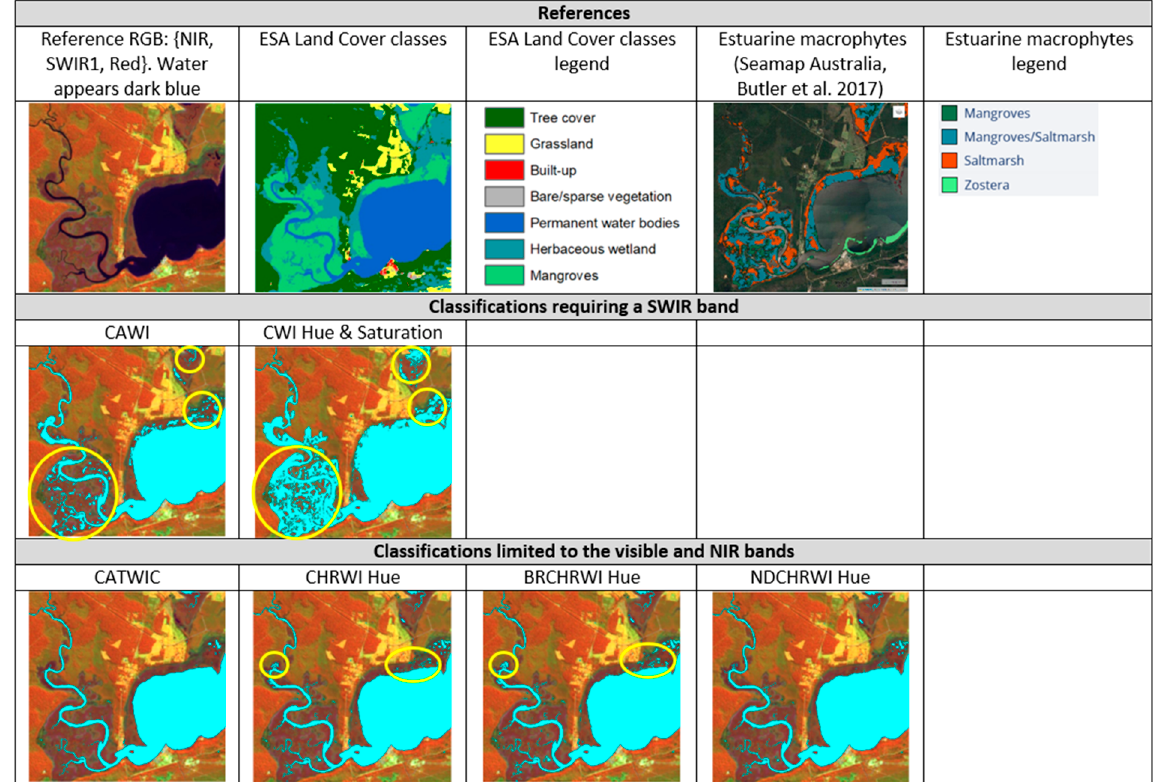
Figure 6. Index performance comparison in a coastal wetland area. Location: Twelve Mile Creek, NSW, Australia (151.92467, − 32.7285). Reference RGB: NIR, SWIR1, Red, min: 0, max: 0.3. Yellow circles indicate misclassifications. Estuarine macrophytes from Seamap Australia (Bulter et al. 2017).